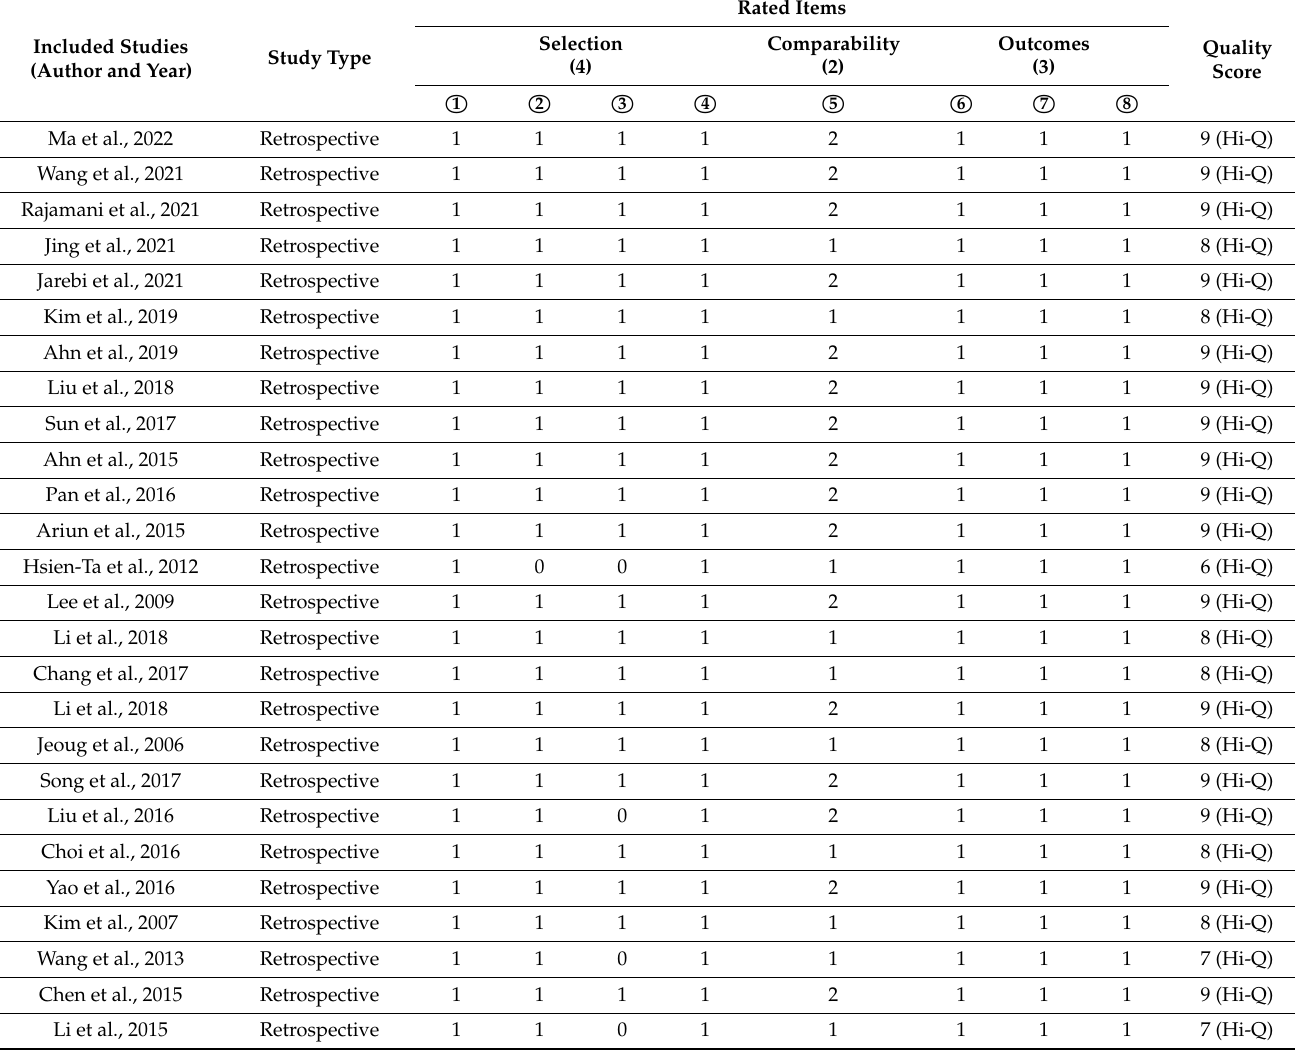
Table 2. Quality evaluation of retrospective clinical studies.